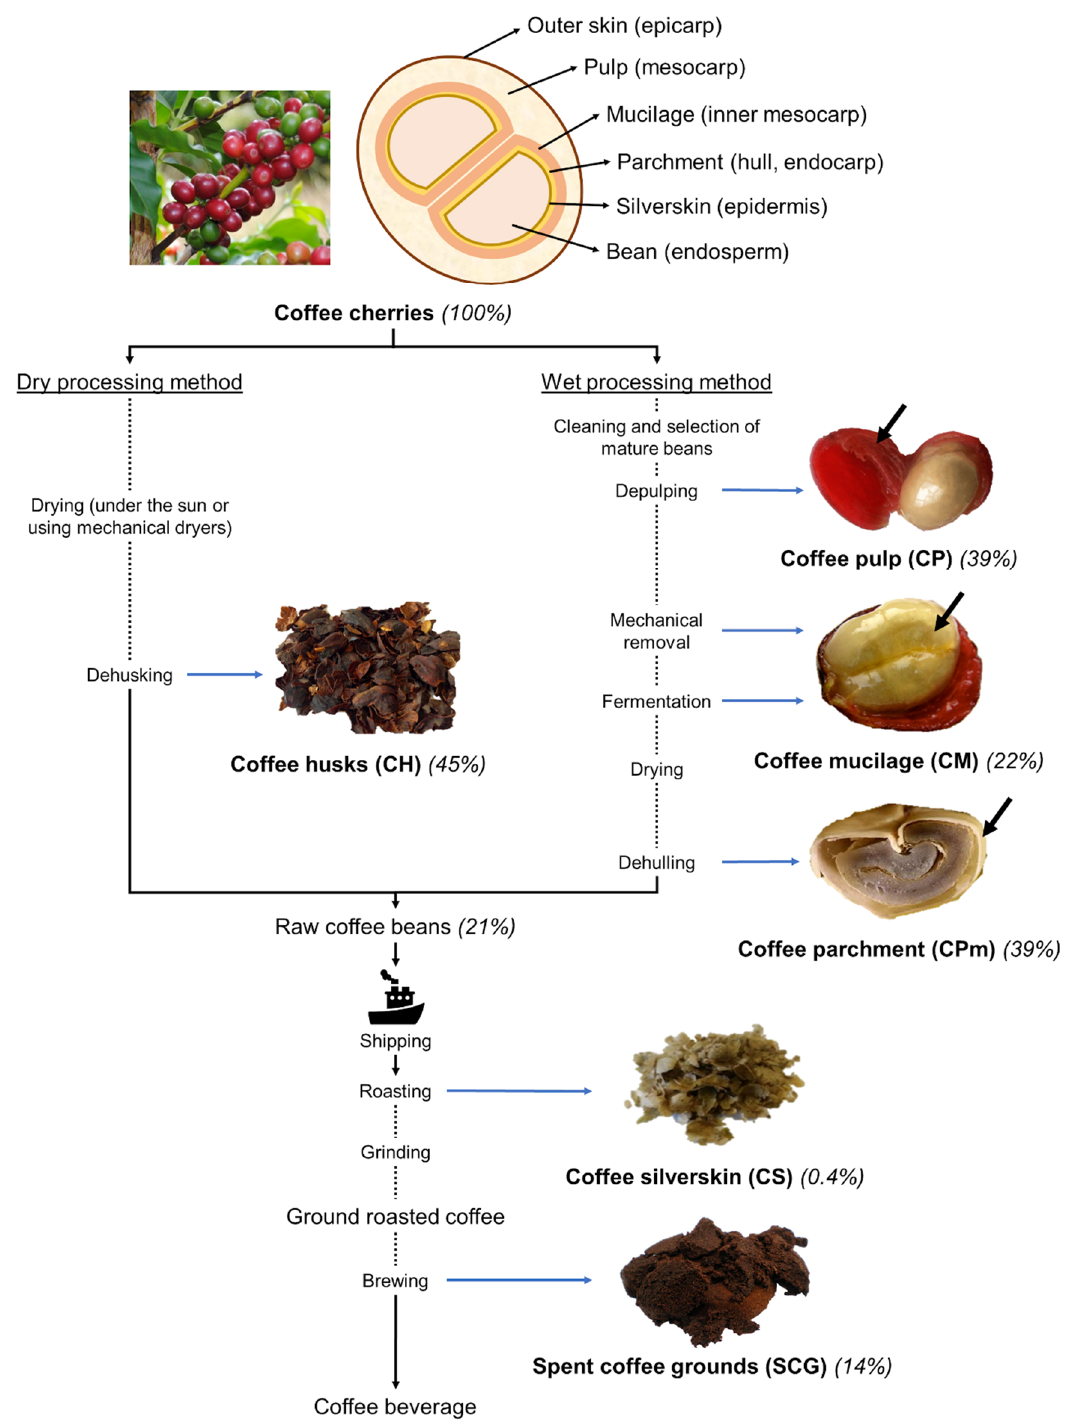
Figure 1. Schematic representation of coffee cherry structure and coffee processing-derived by-products. The percentages refer to the amount of each by-product obtained from fresh coffee cherries.